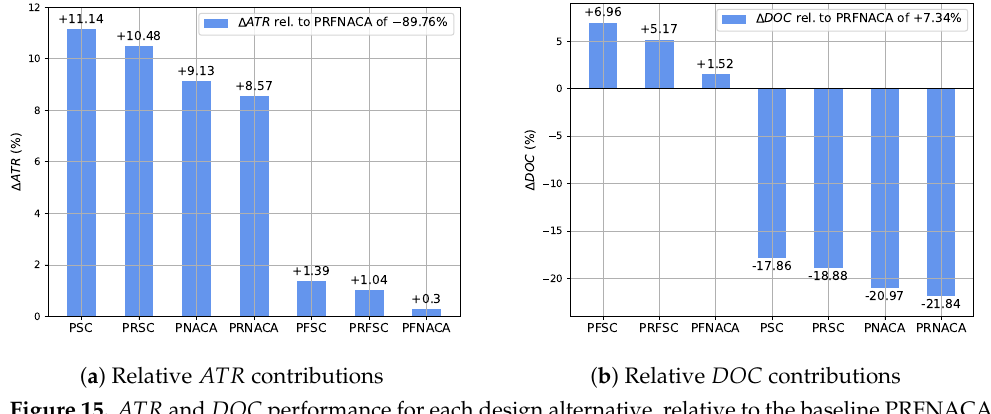
Figure 15. ATR and DOC performance for each design alternative, relative to the baseline PRFNACA which adopts all of the novel design